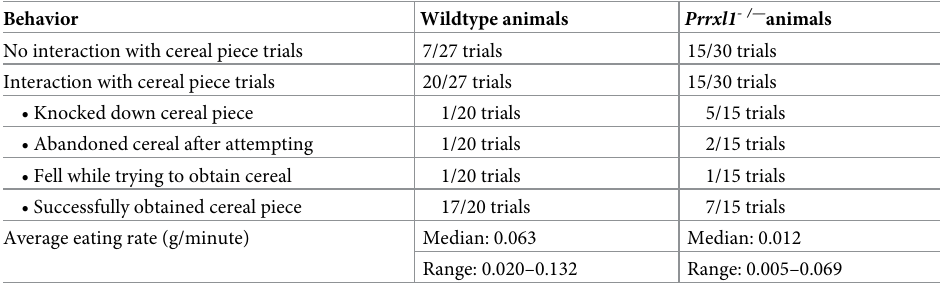
Table 1. Acquisition and consumption of a piece of sugared cereal quantified for WT and Prrxl1 - /— animals. Behavior Wildtype animals Prrxl1 - /— animals No interaction with cereal piece